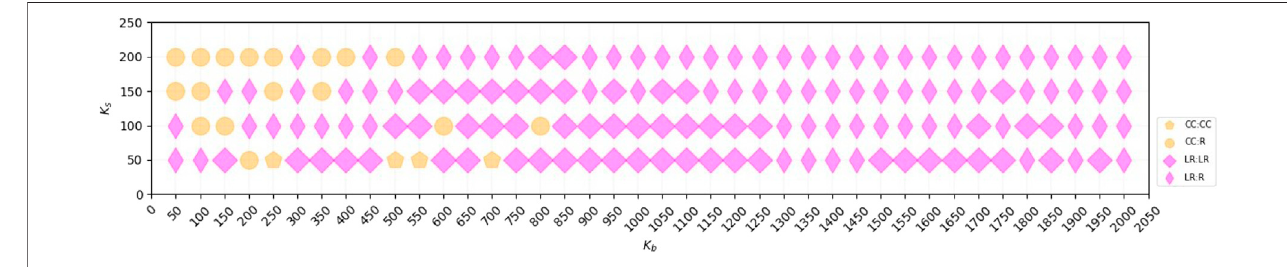
FIGURE 8 | The adversarial strategy pair at dynamic equilibrium obtained by backward induction solving on real online social network from Facebook. Where the horizontal axis denotes the number of seed nodes K b for the blocker and the vertical axis denotes the number of seed node K s for the spreader.